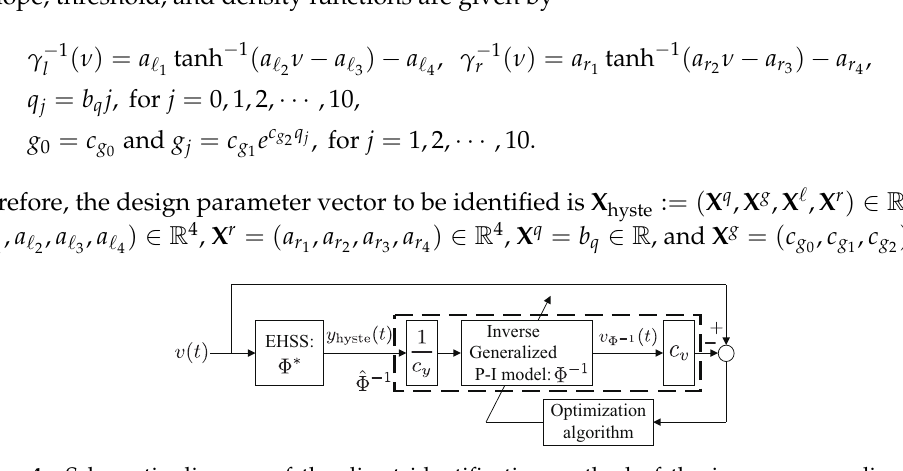
Figure 4. Schematic diagram of the direct identification method of the inverse generalized P–I model ˆ Φ − 1